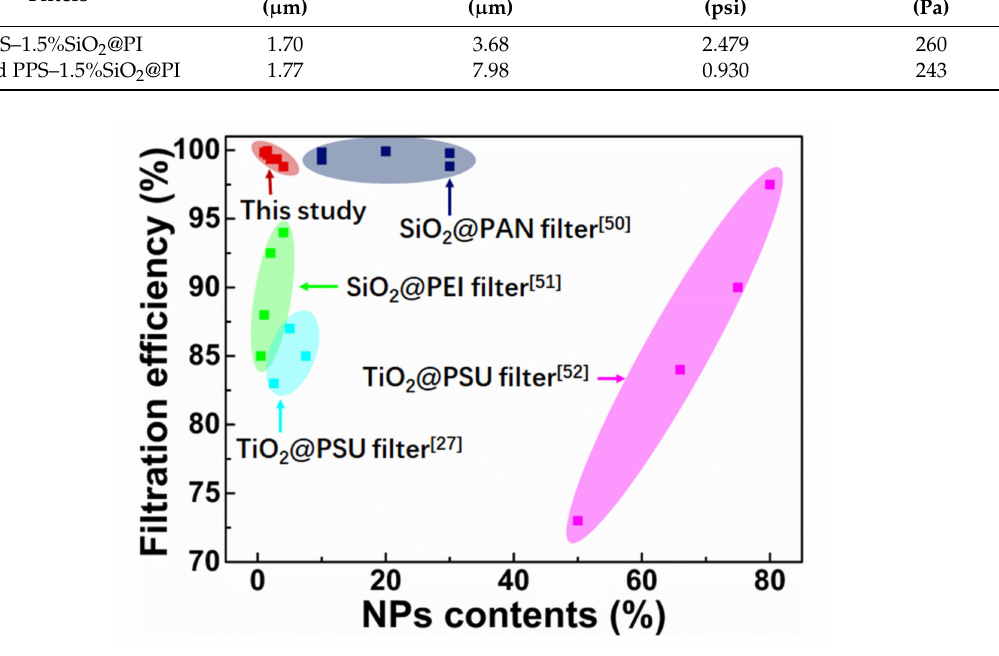
Figure 10. Ashby plot of NP contents versus filtration e ffi ciency for other inorganic NP-filled polymer hybrid